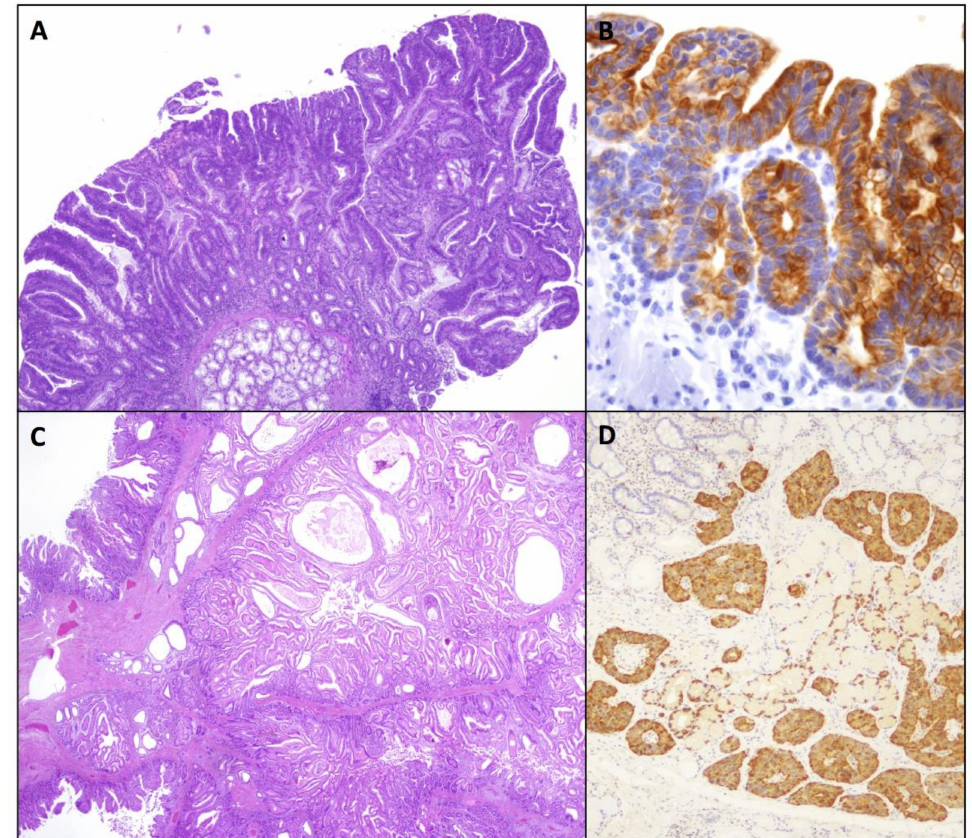
Figure 3. Precursor epithelial (glandular and neuroendocrine) lesions occurring in a background of hereditary tumor syndromes or immune-mediated disorders. ( A ) MUTYH -associated polyposis syndrome-associated non-ampullary duodenal adenoma showing high grade dysplasia. ( B ) Cytoker- atin 7 positive ileal flat dysplasia adjacent to a small bowel adenocarcinoma associated to Crohn’s disease. ( C ) Peutz-Jeghers polyp. ( D ) Gastrin cell preneoplastic lesions in a patient affected by multi- ple endocrine neoplasia type 1 syndrome-related duodenal gastrinomas, including enlarged nodules and microinvasive lesions, in close relationship with linear and nodular gastrin cell hyperplasia of Brunner’s glands. Patients signed informed consent regarding publishing their data before having their endoscopic/surgical